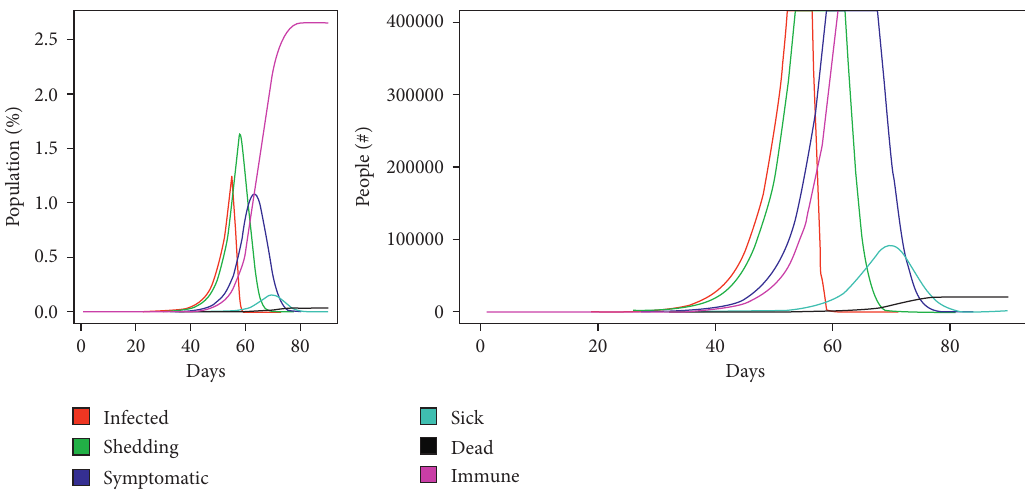
Figure 7: Model simulations implementing perfect social distancing with R